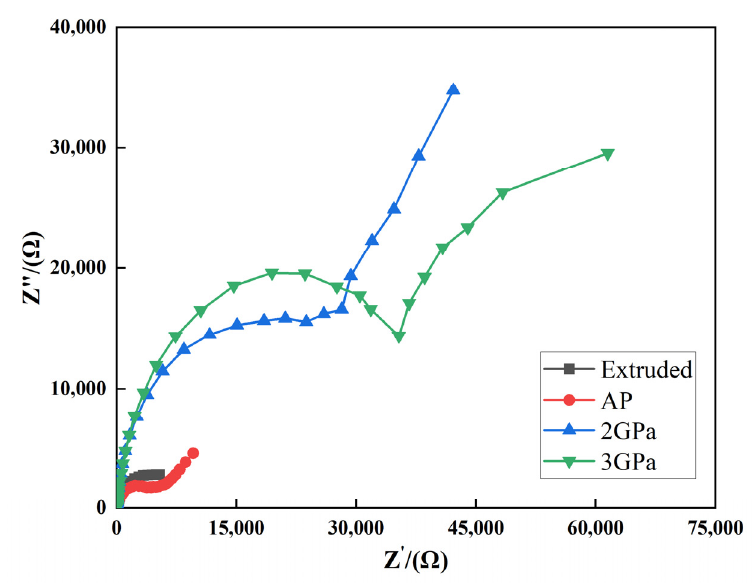
Figure 7. The Nyquist impedance plots for the extruded Al-Zn-Mg-Cu-based samples annealed as a function of pressure in 3.5 wt.% NaCl solution. Materials 2021 , 14 , x FOR PEER REVIEW